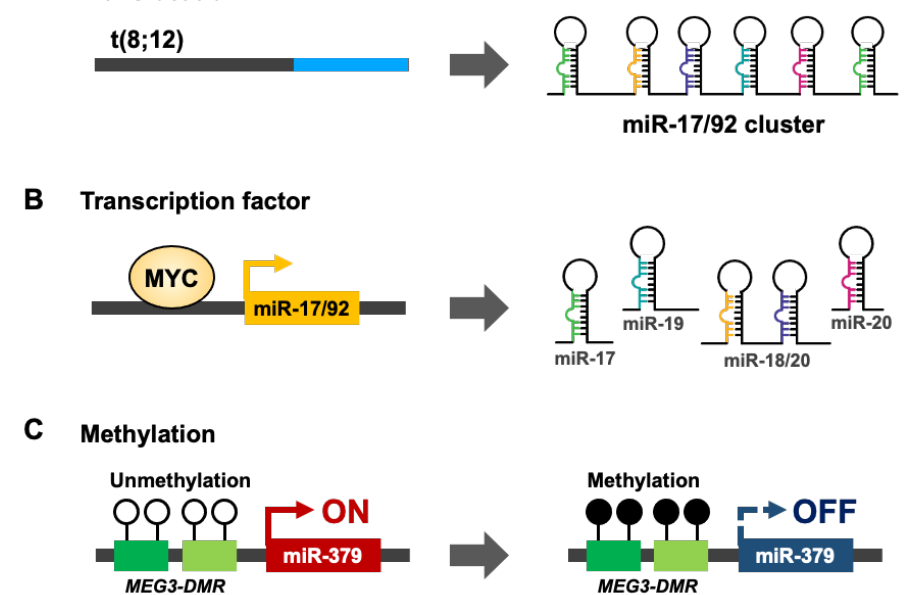
Figure 2. The regulation mechanisms of microRNA clusters in carcinogenesis. ( A , B ) Expression of microRNA cluster is regulated by genetic events. miR-17/92 cluster is stimulated by chromosome t(8;12) translation ( A ) or transcriptional activation by transcription factor MYC ( B ). ( C ) The epigenetic regulation of miR-379/656 cluster upon DNA hypermethylation on MEG3-DMR.